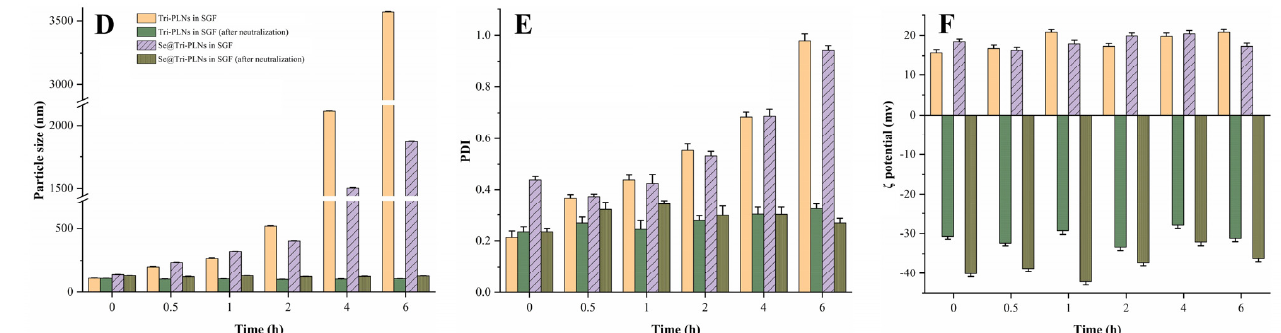
Figure 4. Stability of Tri ‐ PLNs and Se@Tri ‐ PLNs in biorelevant fluids: ( A – C ) changes in particle size, PDI and ζ potential of Tri ‐ PLNs and Se@Tri ‐ PLNs as incubated with deionized water, SGF and SIF for different times; ( D – F ) changes in particle size, PDI and ζ potential of Tri ‐ PLNs and Se@Tri ‐ PLNs in SGF before and after pH neutralization with sodium hydroxide ( n = 3, mean ± SD).